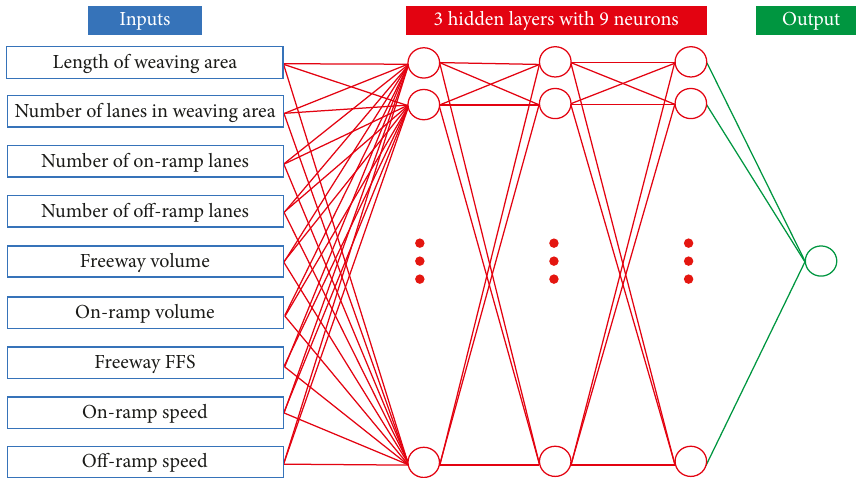
Figure 8: ANN for estimation of the safety level in the weaving